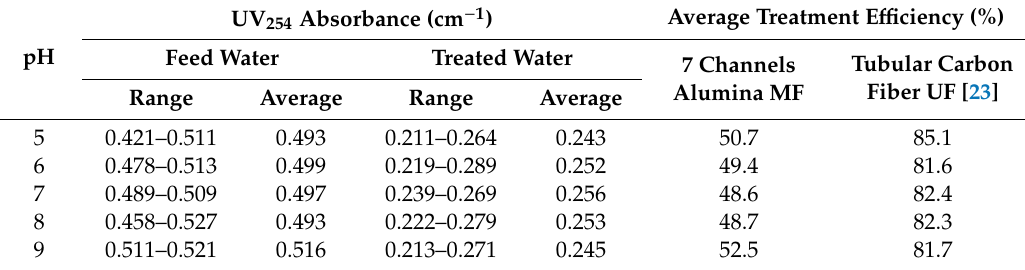
Table 10. Water quality and treatment e ffi ciency of DOM (UV 254 absorbance) in the hybrid process of 7-channel alumina MF (HC10) and PP beads for the e ff ect of pH as compared with results of tubular carbon fiber UF (C005)